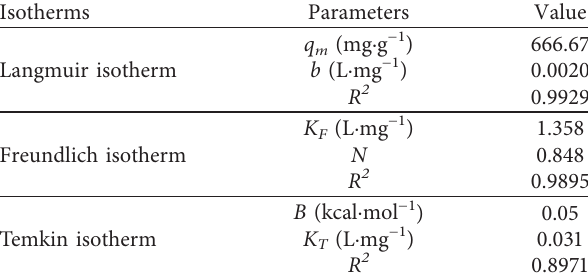
Table 2: Linearized isotherm coefficients for Congo red adsorption onto FBP surface.